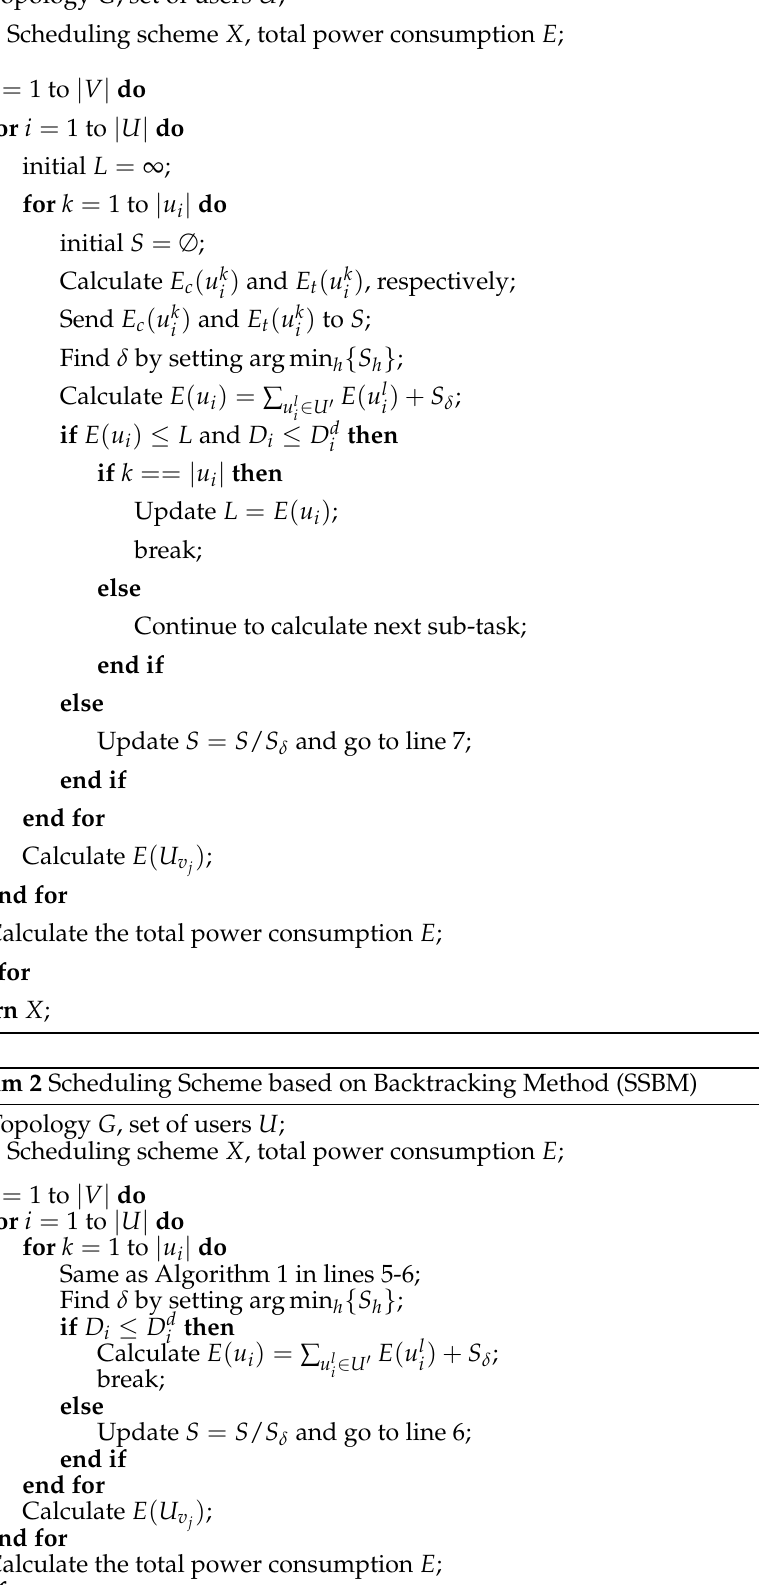
Algorithm 1 Scheduling Scheme based on Branch and Bound Method (SSBB)